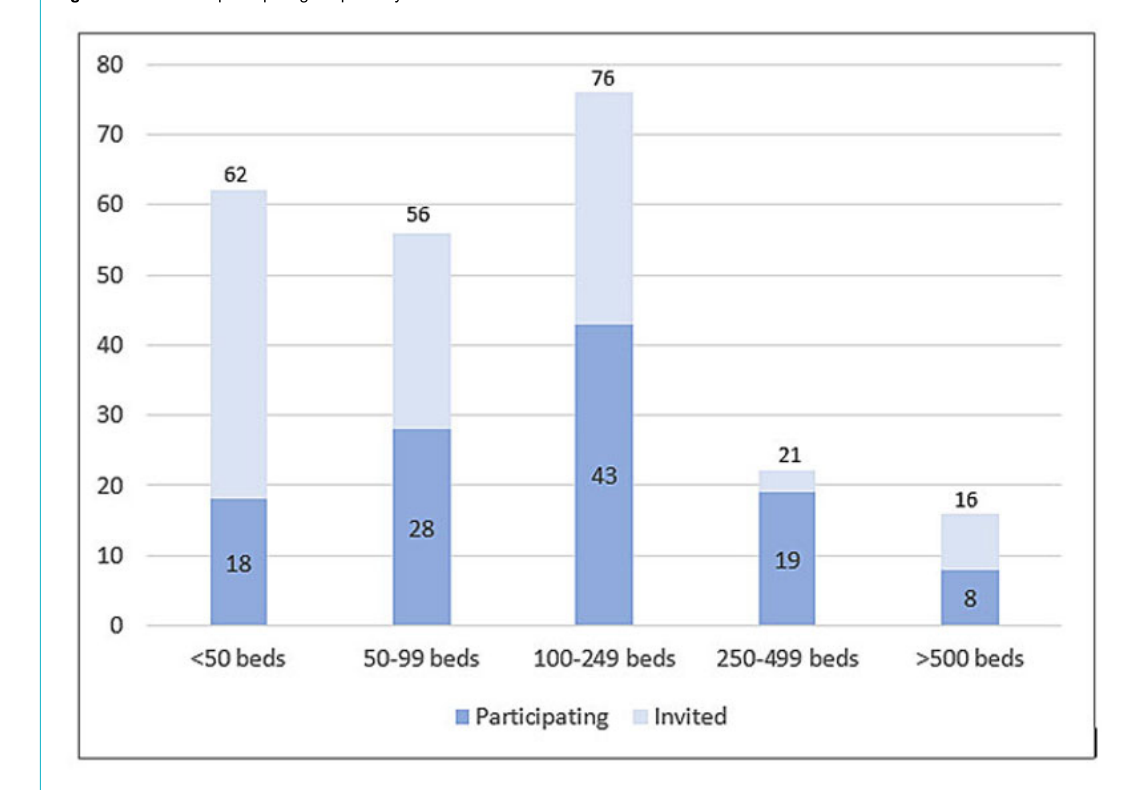
Figure 1: Invited and participating hospitals by number of